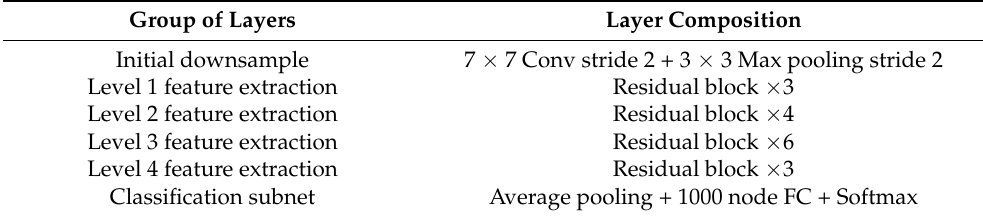
Figure 3. Residual block of Resnet50 [19]. Table 1. Resnet50 model architecture for ImageNet.